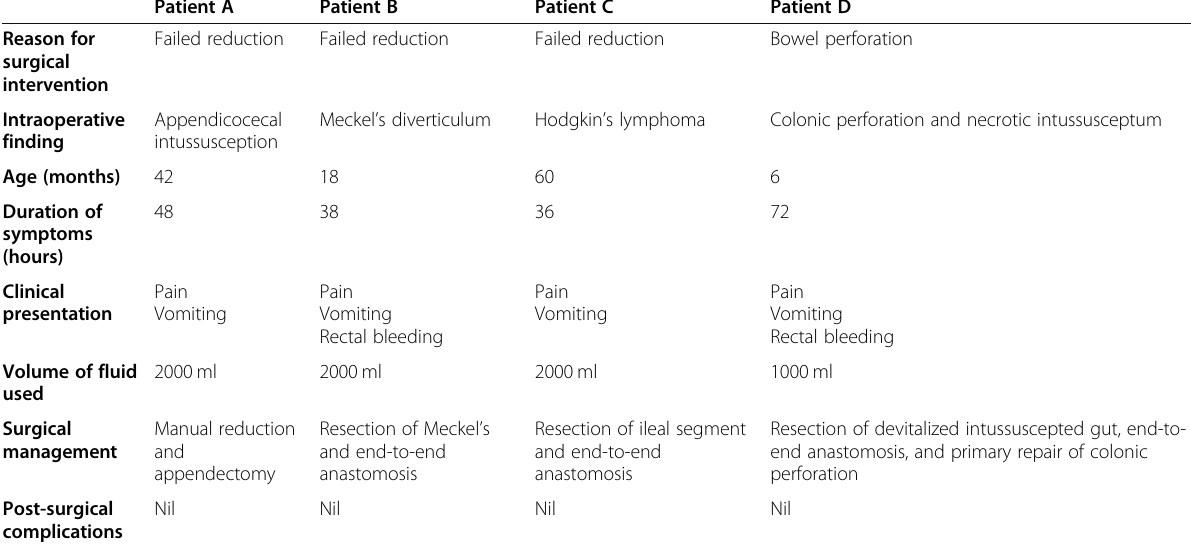
Table 2 Demographic features, clinical presentation, and procedure information of patients with failed non-operative reduction/